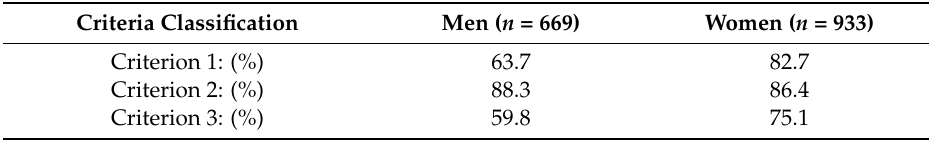
Table 2. Combined classification for total water intake (TWI) following established criteria.